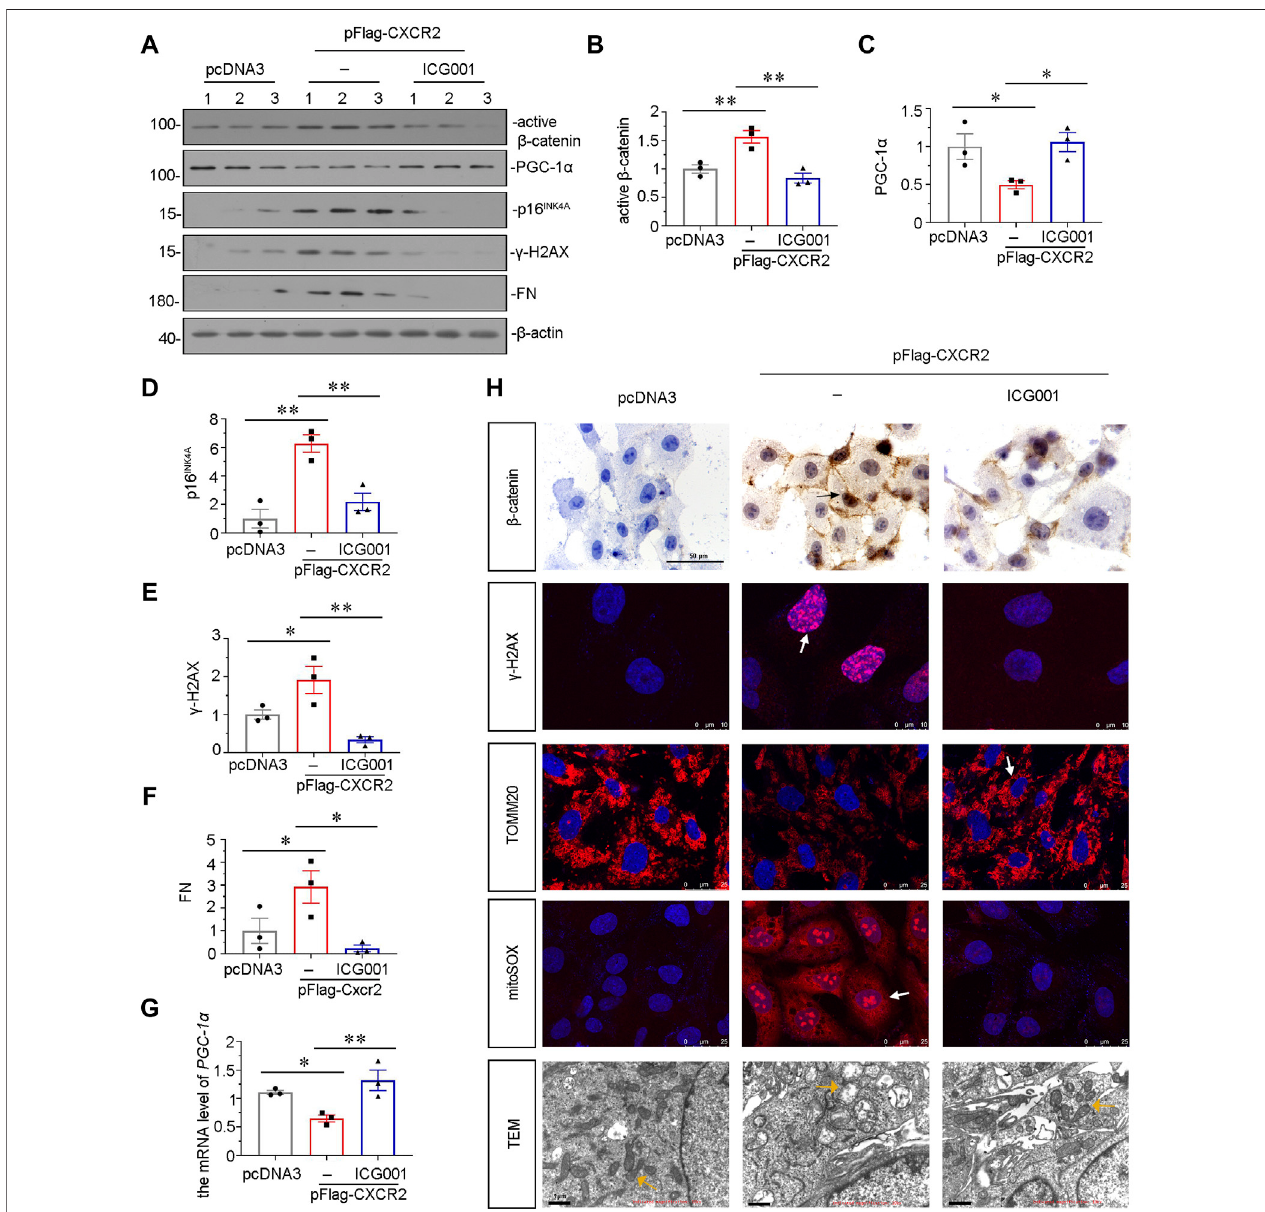
FIGURE8| ICG-001inhibitsCXCR2-aggravatedtubularsenescenceandmitochondrialdysfunction invitro . (A – F) Representativemicrographsofwesternblotand quantitativestatisticaldatashowproteinlevelsof (B) active β -catenin, (C) PGC-1 α , (D) p16 INK4A , (E) γ -H2AXand (F) FNinagivengroup. * p < 0.05,** p < 0.01, n =3. (G) Graphical representations show the relative abundance of PGC-1 α mRNA in each group. * p < 0.05, ** p < 0.01, n = 3. (H) Representative micrographs showing the mitochondrial ROS assessed by mitoSOX staining, and mitochondrial morphology via transmission electron microscopy (TEM) detection, and the expression of β - catenin, γ -H2AX and TOMM20 in different groups, as indicated. Arrows indicate positive staining. Scale bar = 50, 10, 25 or 1 μ m, as indicated.